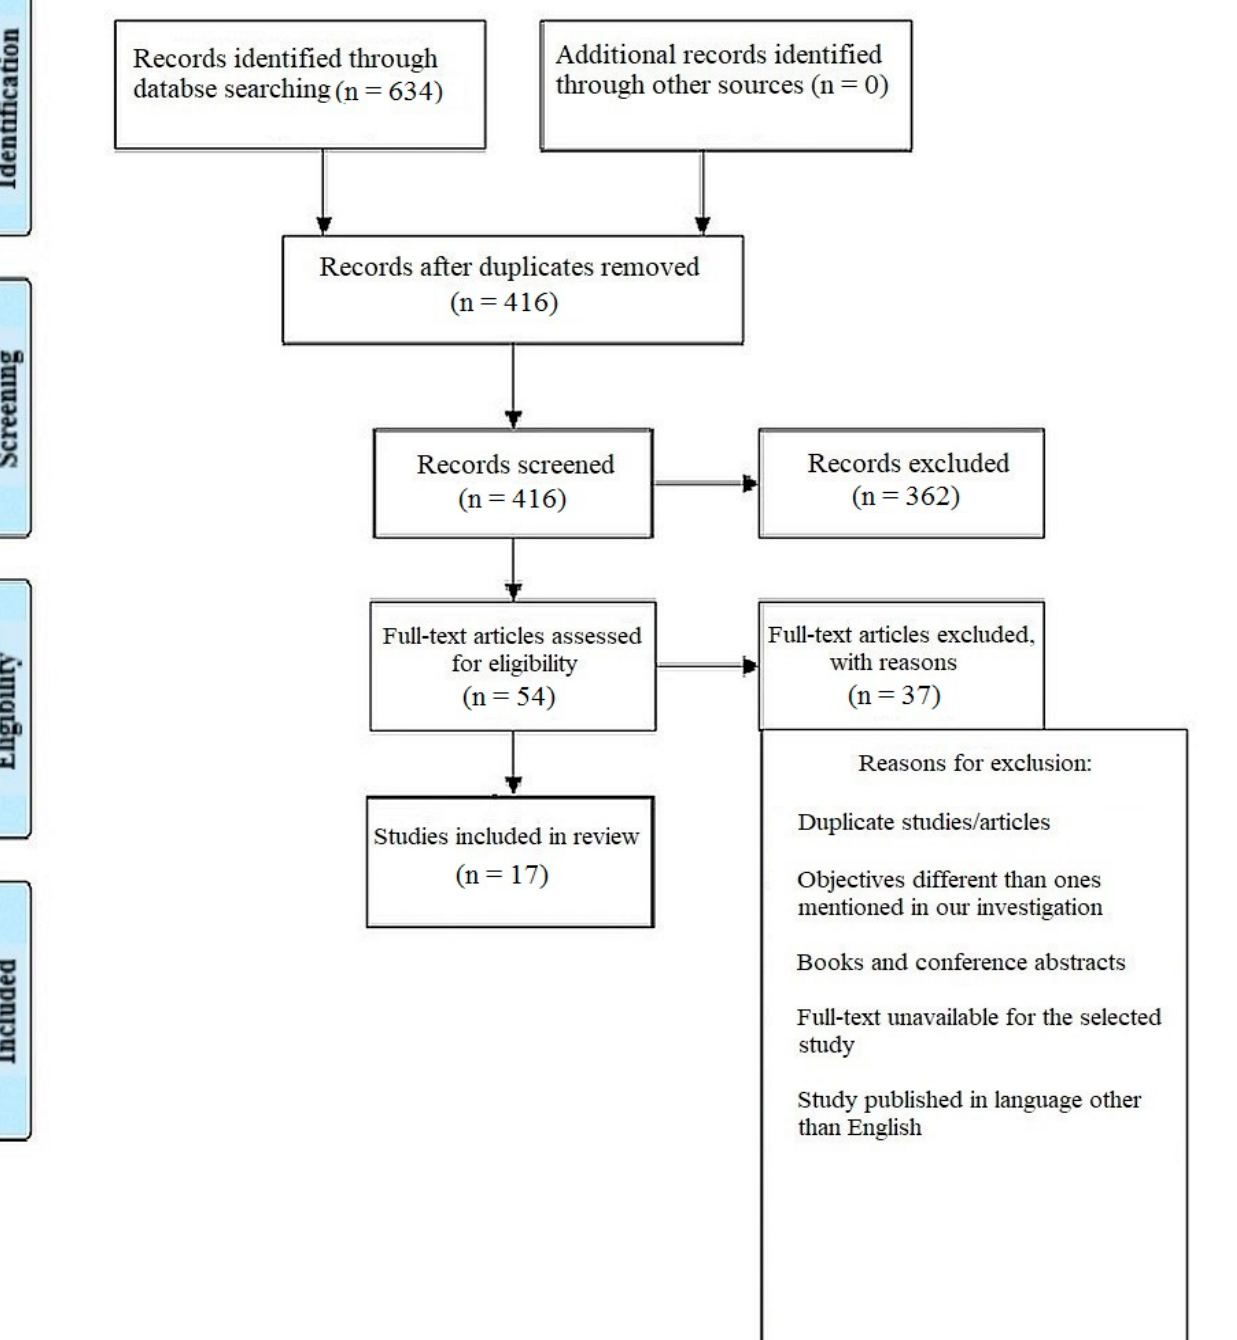
Figure 1. Representation of selection of articles through PRISMA framework.